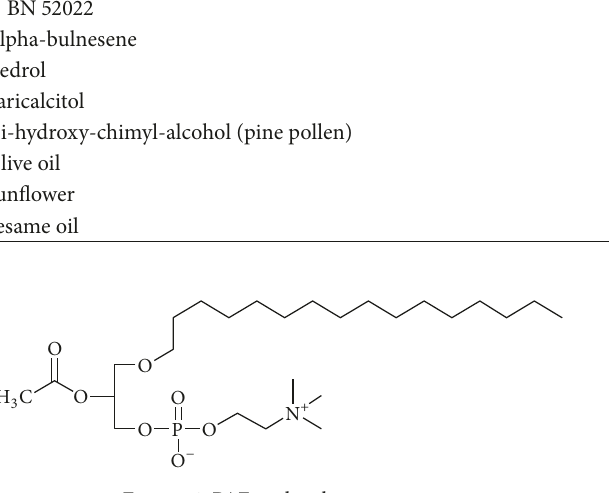
Figure 1: PAF molecular